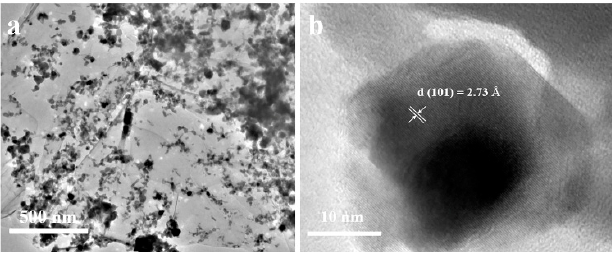
Figure 3. ( a ) TEM image of the NiSe/rGO; ( b ) high resolution TEM image of the NiSe/rGO.